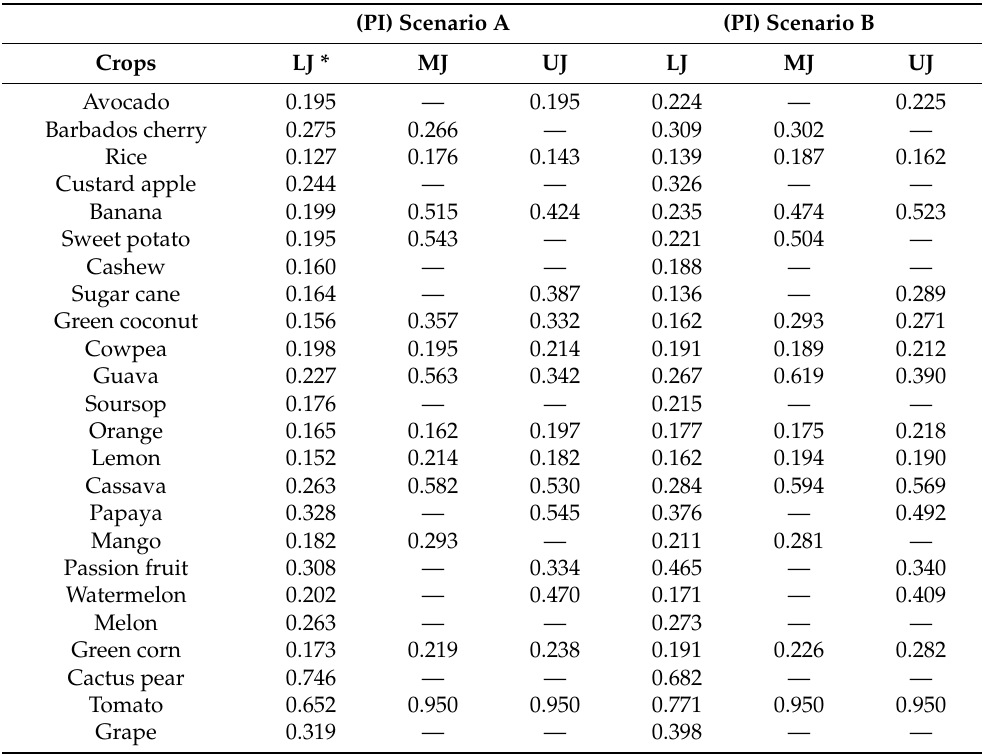
Table 6. Performance index (PI) of irrigated crops in the Jaguaribe River basin, considering two water restriction